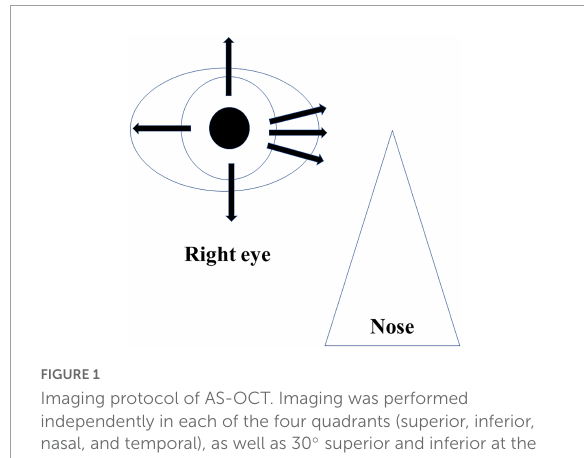
FIGURE1 Imaging protocol of AS-OCT. Imaging was performed independently in each of the four quadrants (superior, inferior, nasal, and temporal), as well as 30 ◦ superior and inferior at the nasal